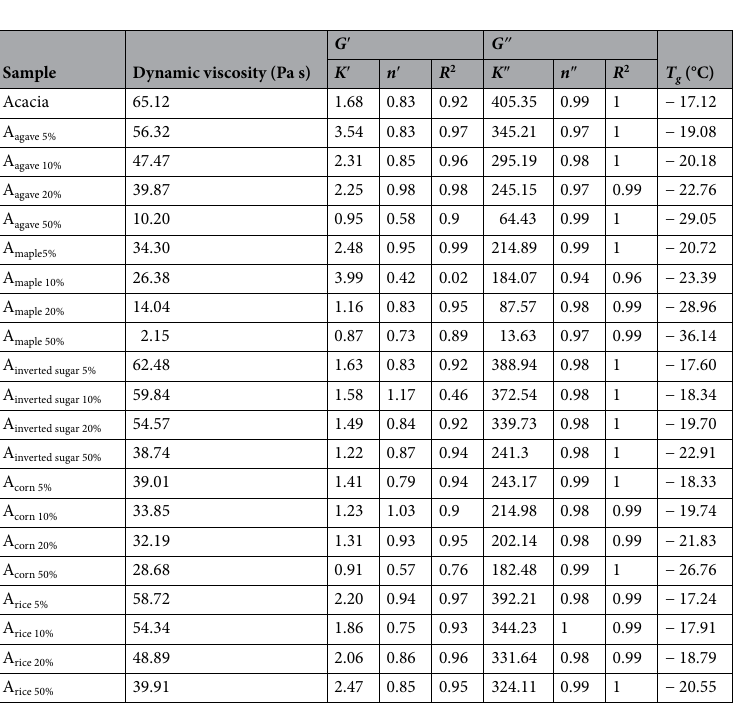
Table 2. Dynamic viscosity and parameters of curve fitting of elastic modulus and loss modulus of acacia honey and adulterated samples with different